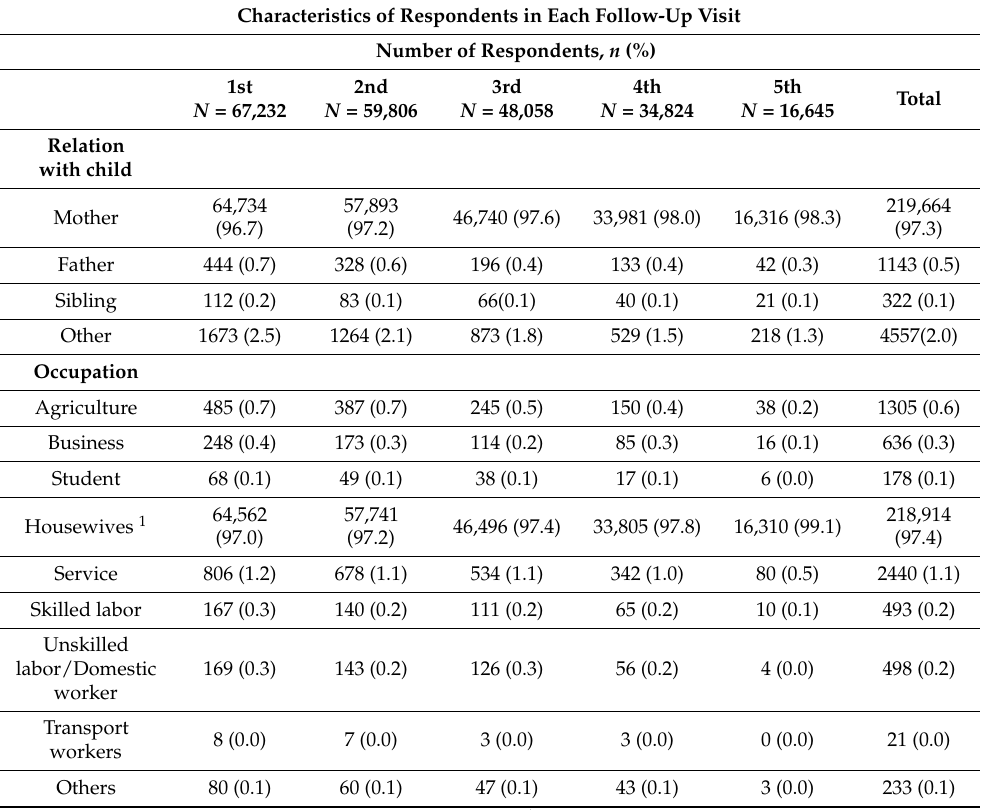
Table 1. Socio-demographic characteristic of respondents for the follow-up